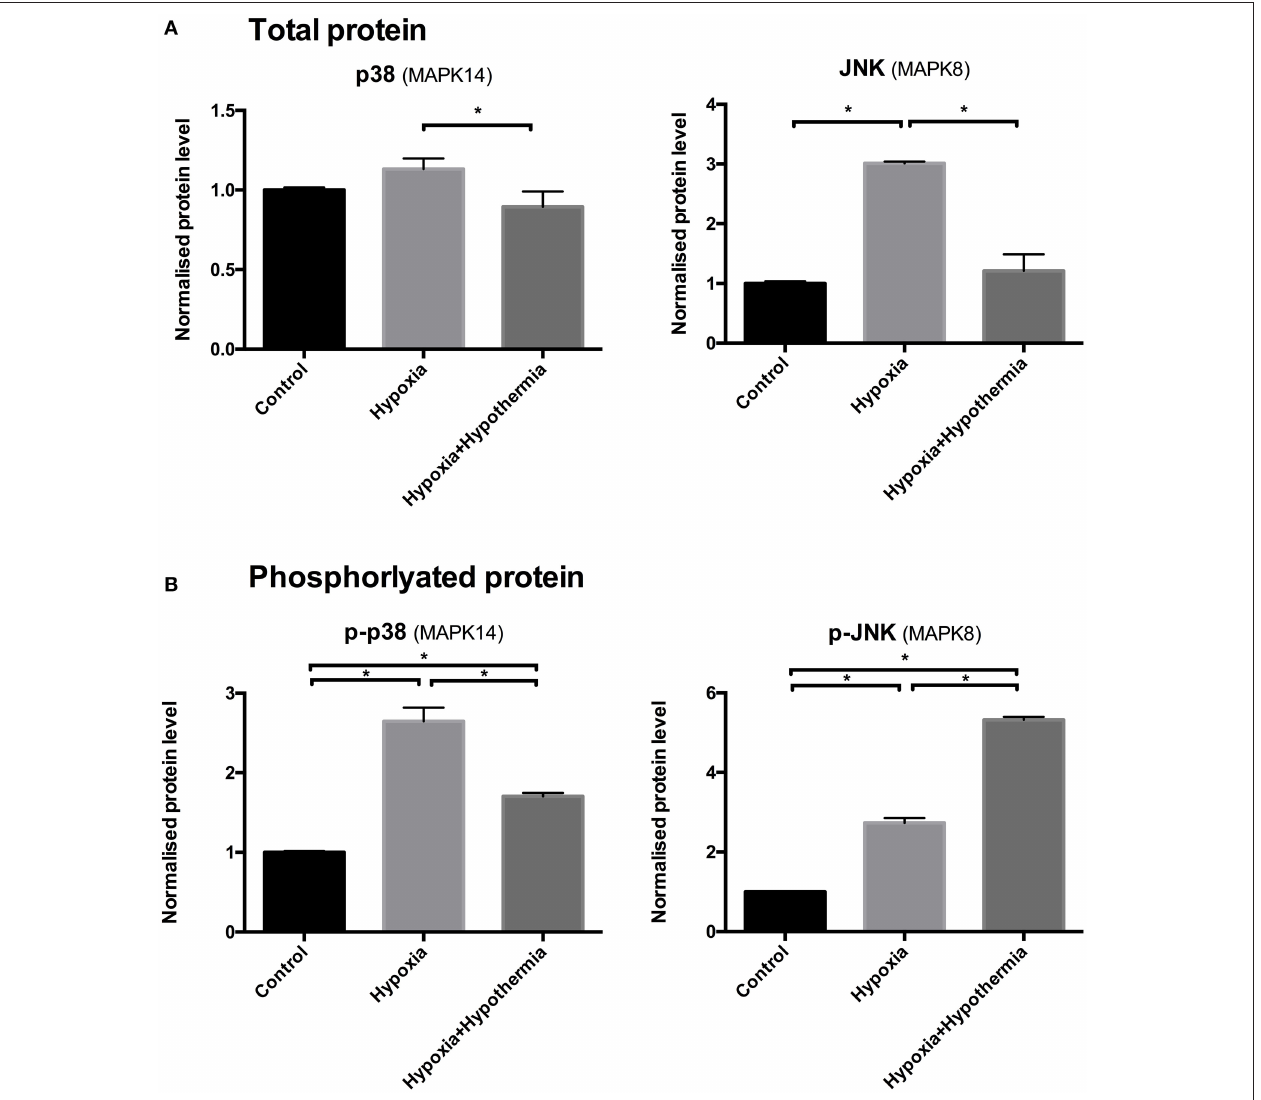
FIGURE 3 | p38 and JNK (A) total and (B) phosphorylated protein levels in cultured human astrocytes using sandwich ELISA. Data are mean fold changes in expression ( ± S.E.M.) of cells incubated at 5% O 2 for 6h (“hypoxia”) and hypothermic intervention after 2h (32 ◦ C; maintaining hypoxia for 6h) (“hypoxia + hypothermia”) normalized to normoxic normothermic (“Control”) astrocytes. Each bar represents the mean ± S.E.M. for each of the conditions ( n = 4). Kruskal-Wallis with Conover-Inman post-hoc analysis tests were used to identify significant differences between samples. *Represents statistical significance ( p <